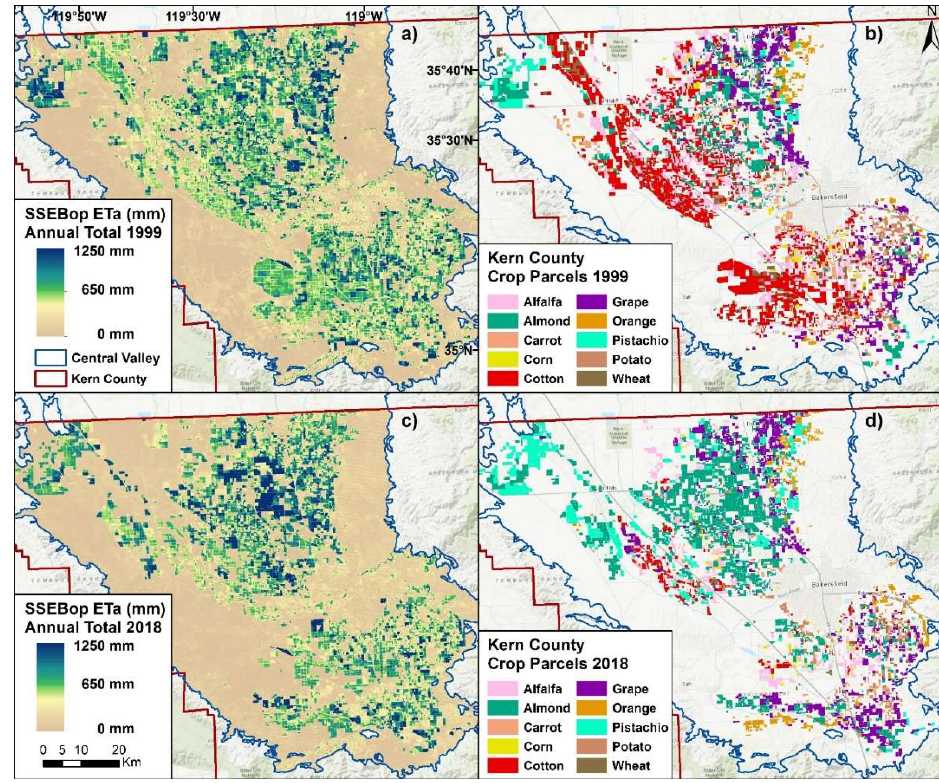
Figure 4. Kern County showing ( a ) 1999 annual total SSEBop ETa , ( b ) major commodity parcels in 1999 identified by Kern County Department of Agriculture and Measurement Standards and filtered by maximum NDVI ≥ 0.5, ( c ) 2018 annual total SSEBop ETa , and ( d ) major commodity parcels in 2018 identified by Kern County Department of Agriculture and Measurement Standards and filtered by maximum NDVI ≥ 0.5.